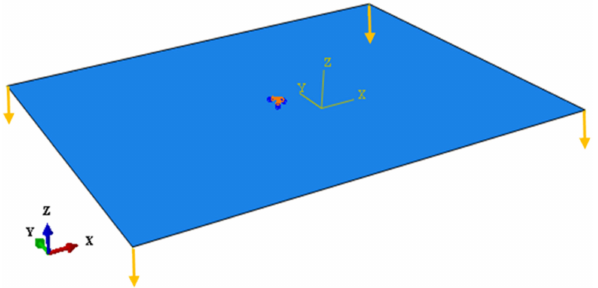
Figure 3. The laminate with the clamped center, and four vertical forces in the